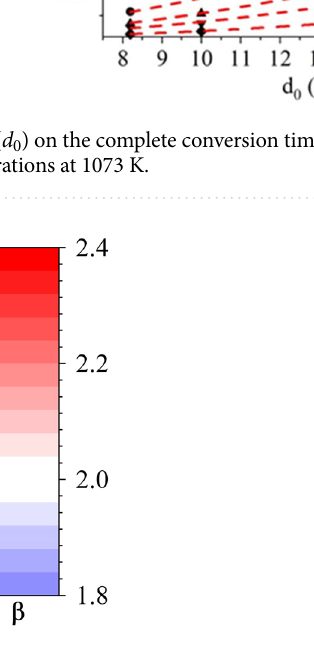
Figure 6. Variation of β over a temperature range of 300–1073 K and oxygen concentration range of